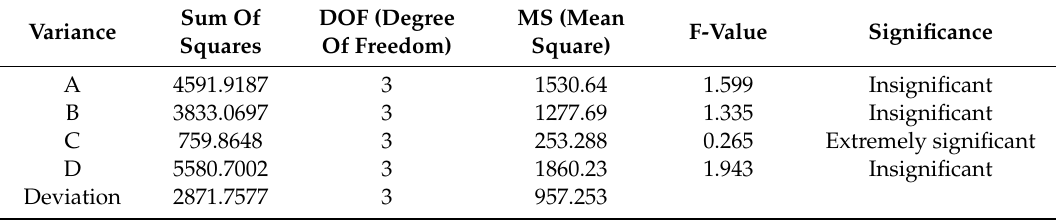
Table 5. The orthogonal experiment results analysis of variance table.